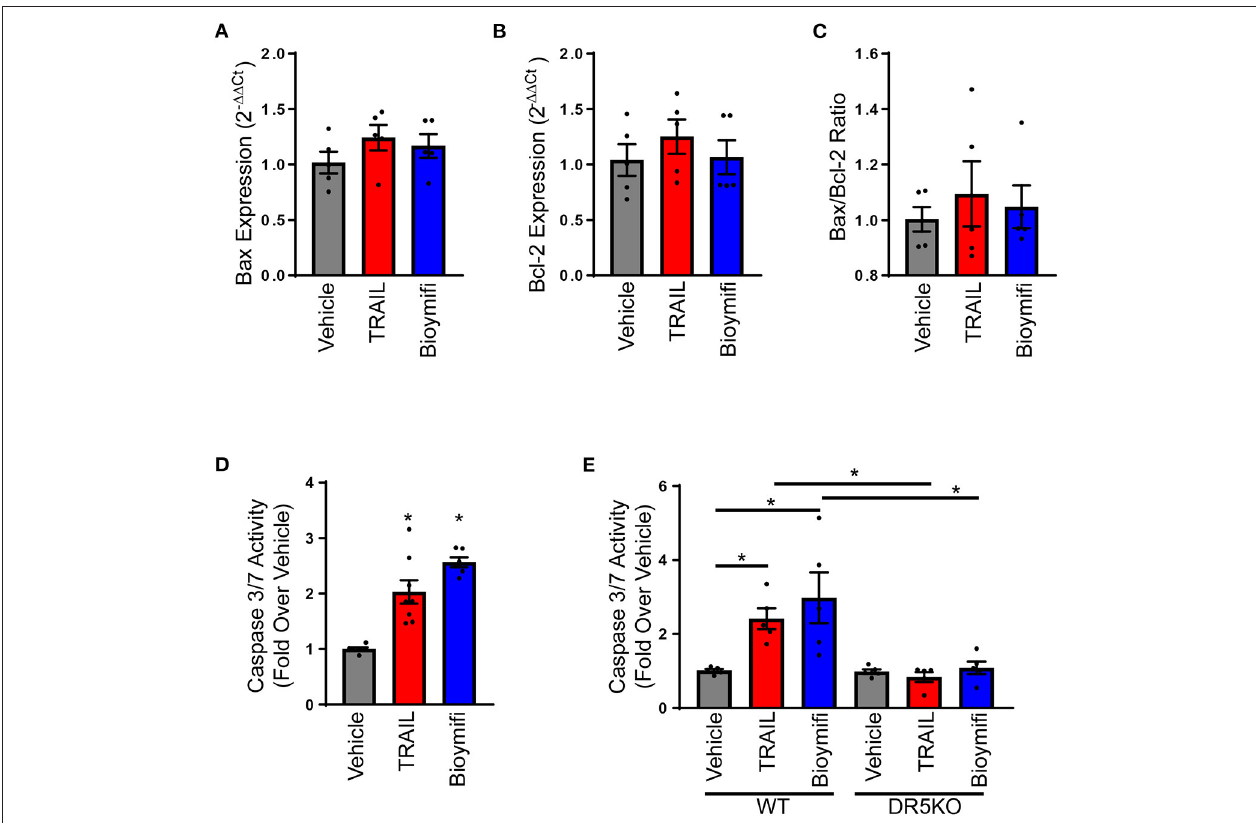
FIGURE 5 | DR5 activation induces apoptosis in myofibroblasts. Bax (A) and Bcl-2 (B) transcript expression and the calculated Bax to Bcl-2 ratio (C) were examined in neonatal rat myofibroblasts treated with vehicle, TRAIL or bioymifi using RT-qPCR and expressed relative to vehicle treated cells. n = 5. (D) A Caspase 3/7 Activity assay was used to measure apoptosis in myofibroblasts treated with TRAIL, bioymifi, or vehicle control. Values are expressed relative to vehicle. n = 6, One-Way ANOVA, * p < 0.05 vs. vehicle. (E) Apoptosis was quantified in WT and DR5KO myofibroblasts from adult mouse heart and treated with vehicle, TRAIL or bioymifi. Values are expressed relative to WT vehicle. n = 5, One-Way ANOVA, * p <